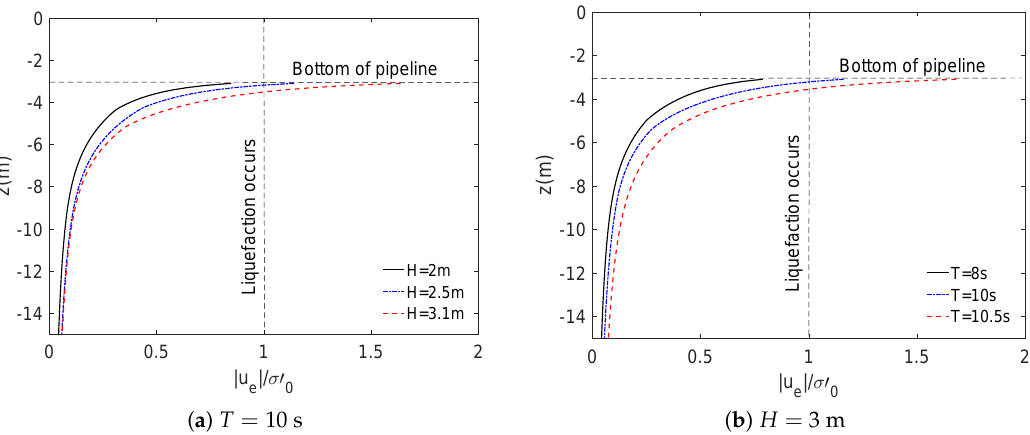
Figure 10. Distribution of the excess pore pressure ( | u e | / σ (cid:48) section through the center of the pipeline for various wave characteristics.